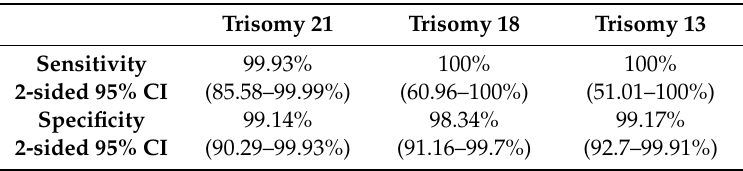
Table 3. Sensitivity and specificity of the method for the sample set. Confidence interval was determined based on Wilson’s score